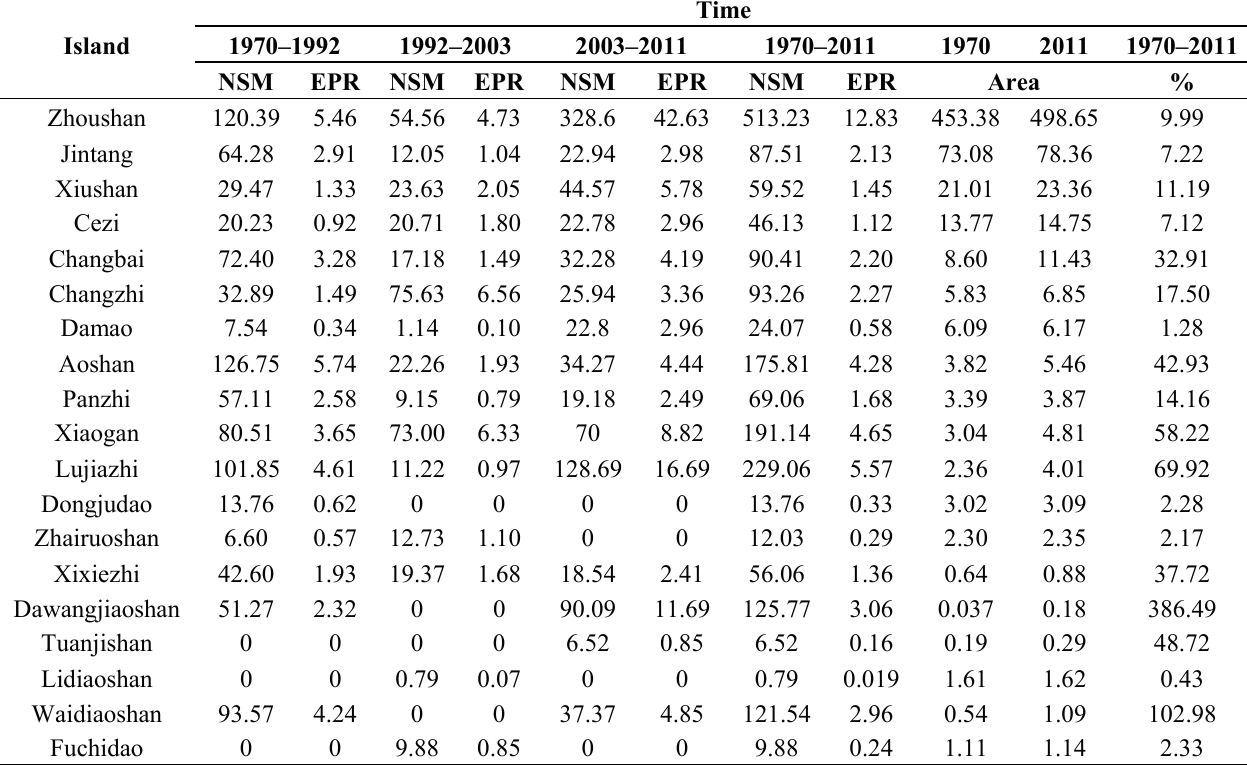
Table 4. The net shoreline movement (NSM) (m), end point rate (EPR) * (m/year) and area (km 2 ) of the Zhoushan Islands during different time